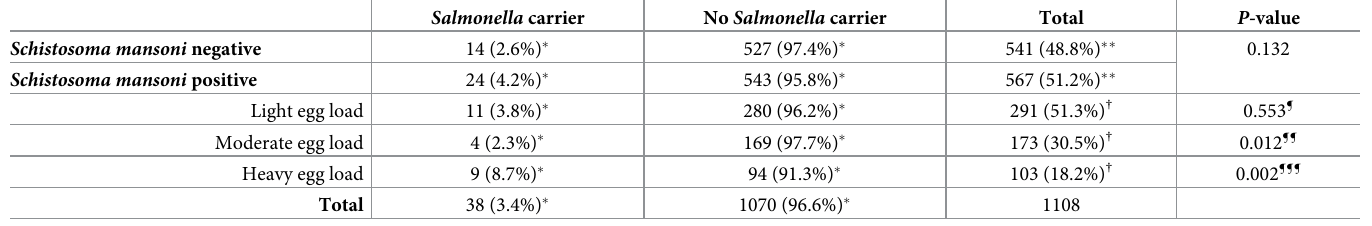
Table 1. Number of participants with Salmonella intestinal carriage and Schistosoma mansoni infection in Kifua II, including the distribution of Schistosoma man- soni egg loads for Schistosoma mansoni positive